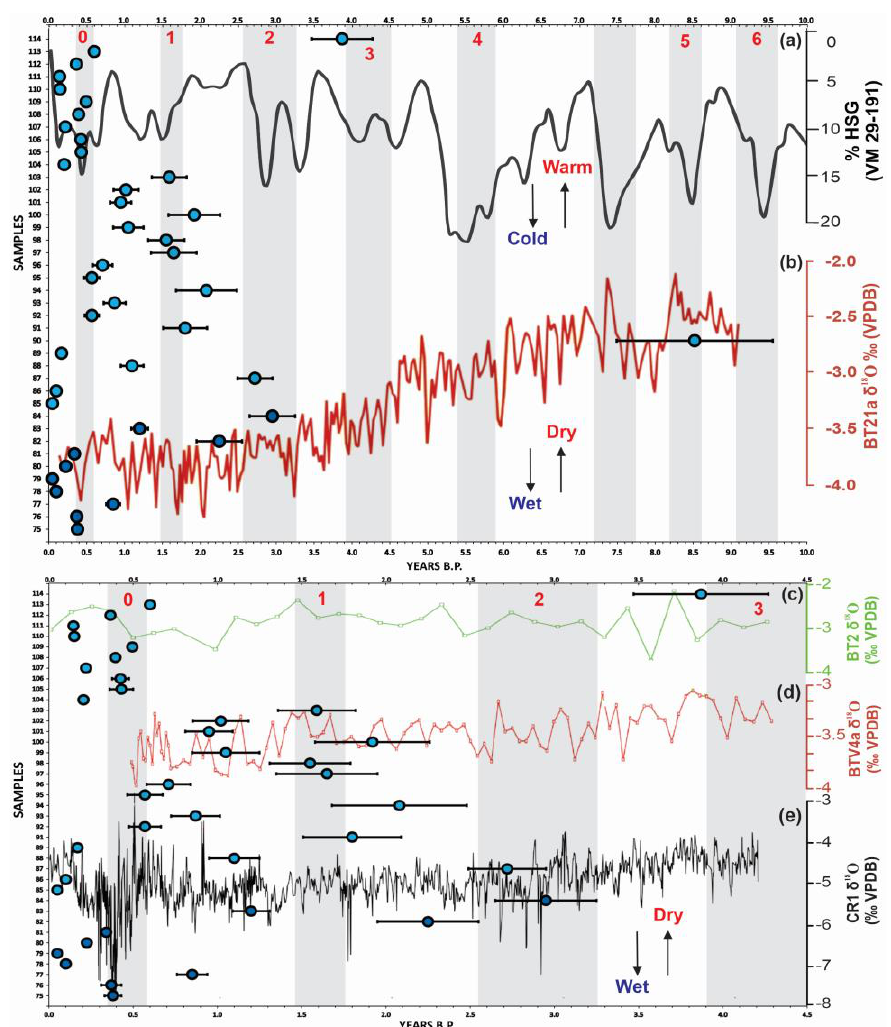
Figure 9. ( a ) Record of hematite-stained quartz grains (HSG) from the North Atlantic marine core VM 29 – 191 [15,54] ( b ) Composite record of δ18O from stalagmite BT21a, Botuverá cave, Southern Brazil [86] ( c ) Composite record of δ18O from stalagmite BT2, Botuverá cave, Southern Brazil [85]. ( d ) Composite record of δ18O from stalagmite BTV4a, Botuverá cave, Southern Brazil [87]. ( e ) Com- posite record of δ18O from stalagmite CR1, Cristal cave, Southeastern Brazil [88]. Dots correspond to ages obtained by OSL dating for materials from low river terraces [36,69,72,73,76] (Unpublished data in Supplementary Data). Source: Adapted from Bond et al. [15,54], Bernal et al. [86], Cruz et al. [85], Wang et al. [87], Taylor [88], Strikis et al. [79], Cheng et al. [80], and Zielhofer et al. [81].